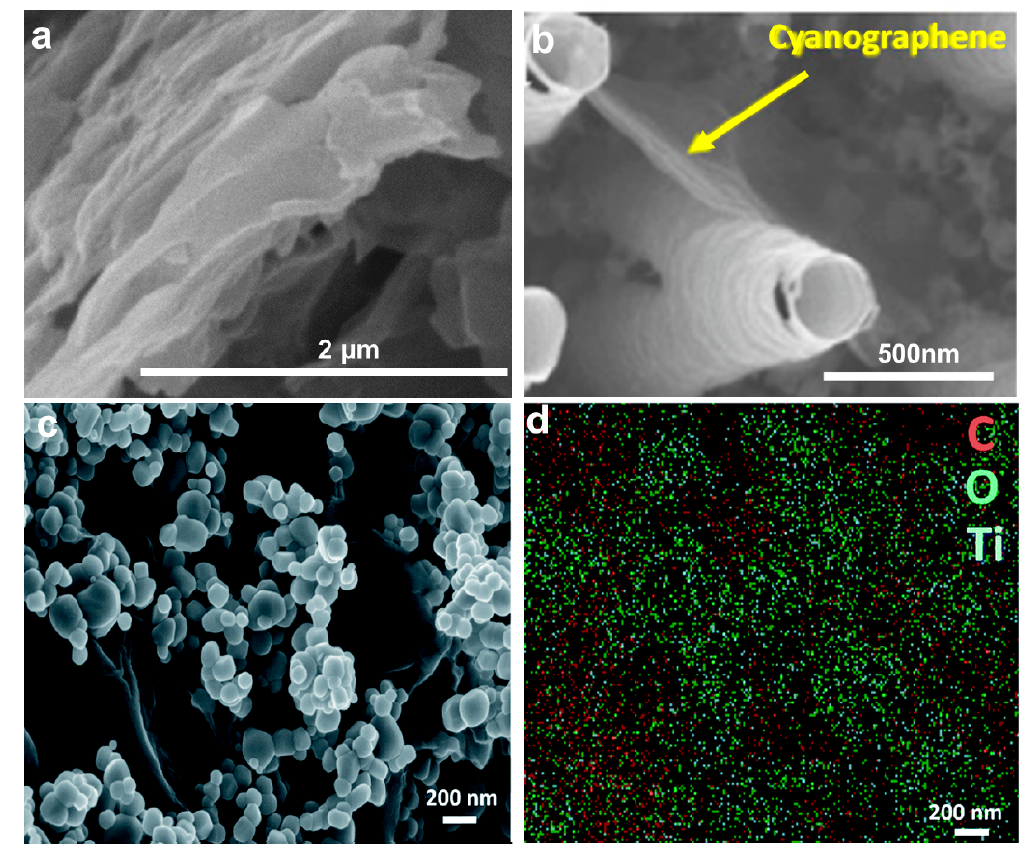
Figure 8. SEM images of ( a ) GO nanosheets [9] (Reprinted with permission from [9] Copyright 2020 Elsevier Ltd.) and ( b ) the anodized spaced TiO 2 nanotubes with wrapped-around and modified nanosheets of graphene [138] (Reprinted with permission from [138] Copyright 2020 MDPI); ( c ) TiO 2 –RGO (5%); ( d ) EDS elemental mapping of the area shown in ( c ) [171] (c,d—Reprinted with permission from [171] Copyright 2020 Royal Society of Chemistry).